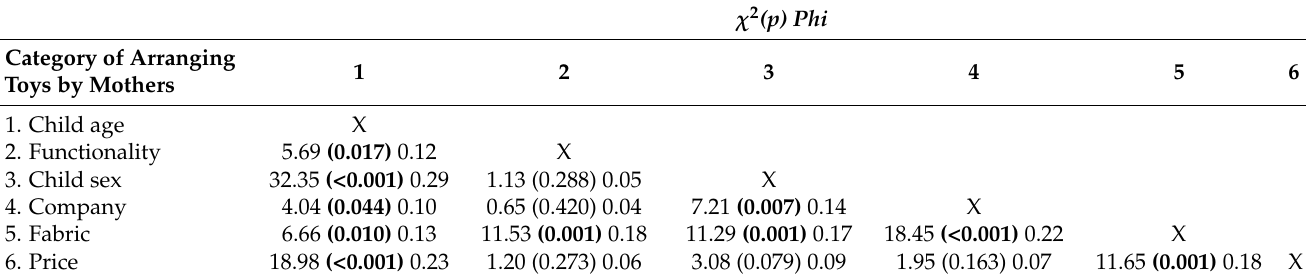
Table 2. Categories of arranging toys in stores—differences in mothers’